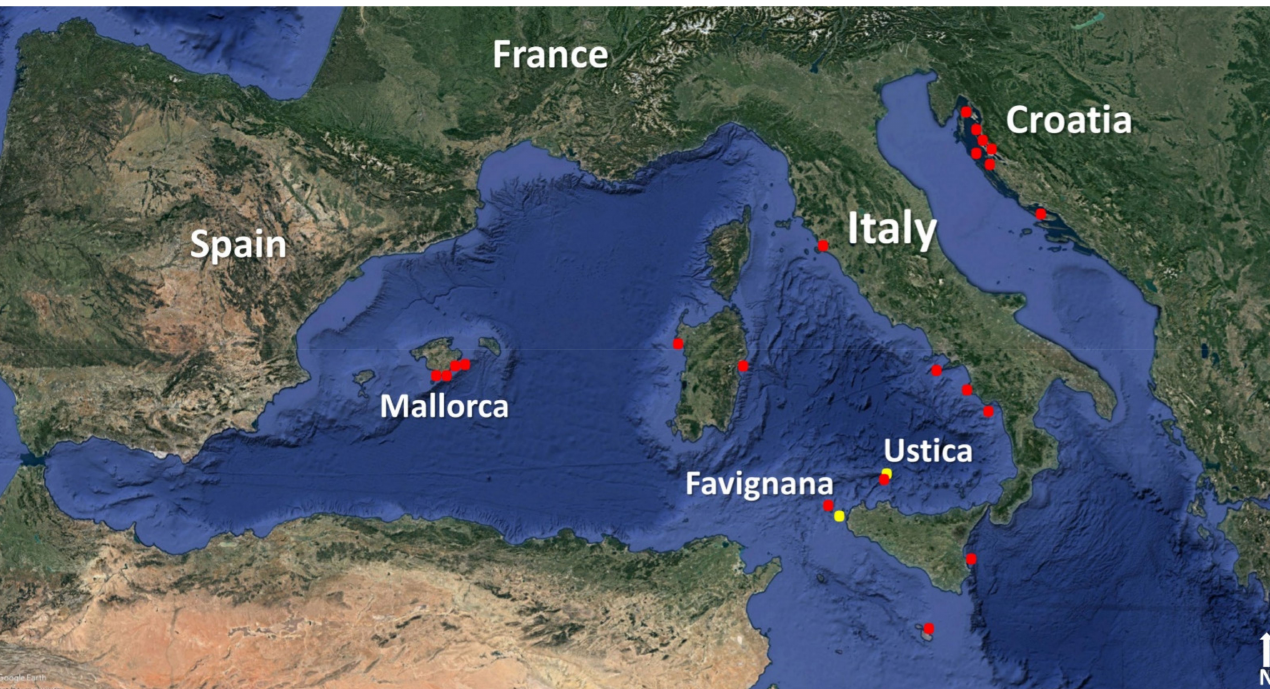
Figure 1. Overview of the Mediterranean region showing the locations (red dots) of the submerged caves discussed in [6] and the new sites (yellow dots) at Favignana and